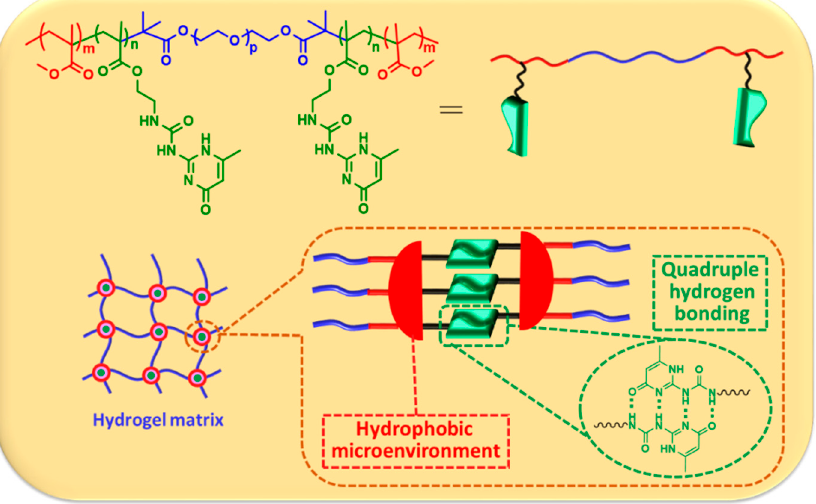
Figure 1. The design of supramolecular hydrogel based on the synergy between hydrophobic interaction and quadruple hydrogen bonding.